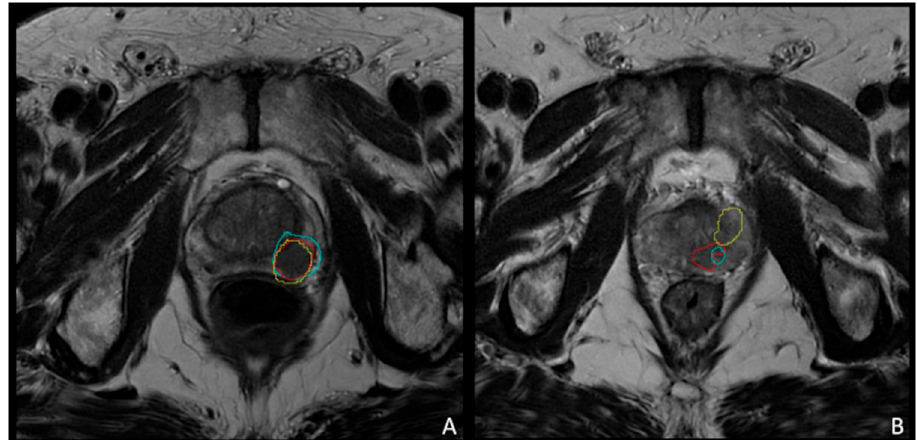
Figure 6. Images representing concordant ( A ) and discordant ( B ) contouring on DICE analysis. ( A ): A 74 years-old patient with biopsy-proven PCa (pt n. 9), Gleason score 9 (5 + 4) with a PSA level at diagnosis of 6.37 ng/mL presenting a prostatic lesion located in the left lobe of the gland. The image shows a concordant identification of the lesion on 68 Ga-PSMA PET images (blue), 68 Ga-DOTA-RM2 PET images (yellow) and MRI (red). DICE SCORE: 68 Ga-PSMA vs. 68 Ga-DOTA-RM2 = 0.6019, 68 Ga-PSMA vs. MRI = 0.7581. 68 Ga-DOTA-RM2 vs. MRI = 0.7220. ( B ): A 52 years-old patient with biopsy-proven PCa (pt n. 14), Gleason score 8 (4 + 4) with a PSA level at diagnosis of 8.04 ng/mL presenting a focal left prostatic. DICE SCORE: 68 Ga-PSMA vs. 68 Ga-DOTA-RM2 = 0.2918, 68 Ga-PSMA vs. MRI = 0.6162. 68 Ga-DOTA-RM2 vs. MRI =